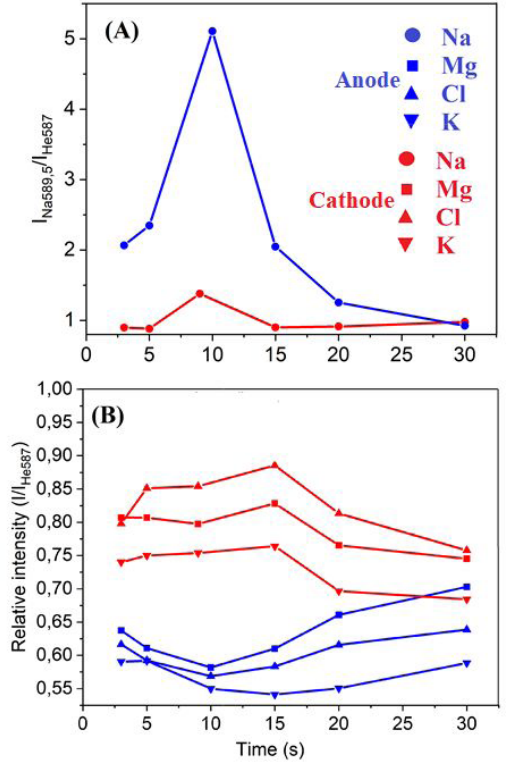
of the OES peak He(587)